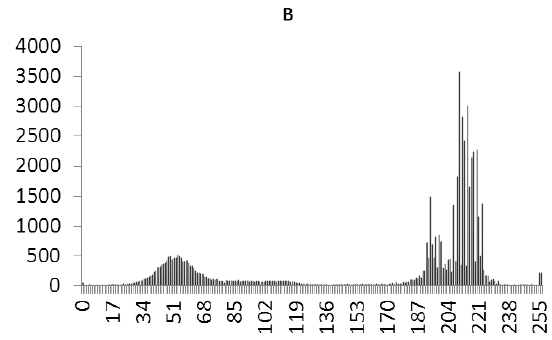
Figure 19. Statistical chart of B value distribution of the original image.